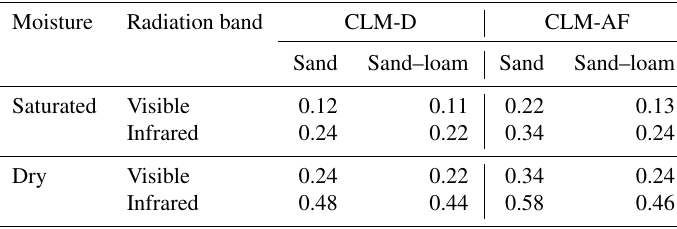
Table 6. Sandy soil CLM albedo values.